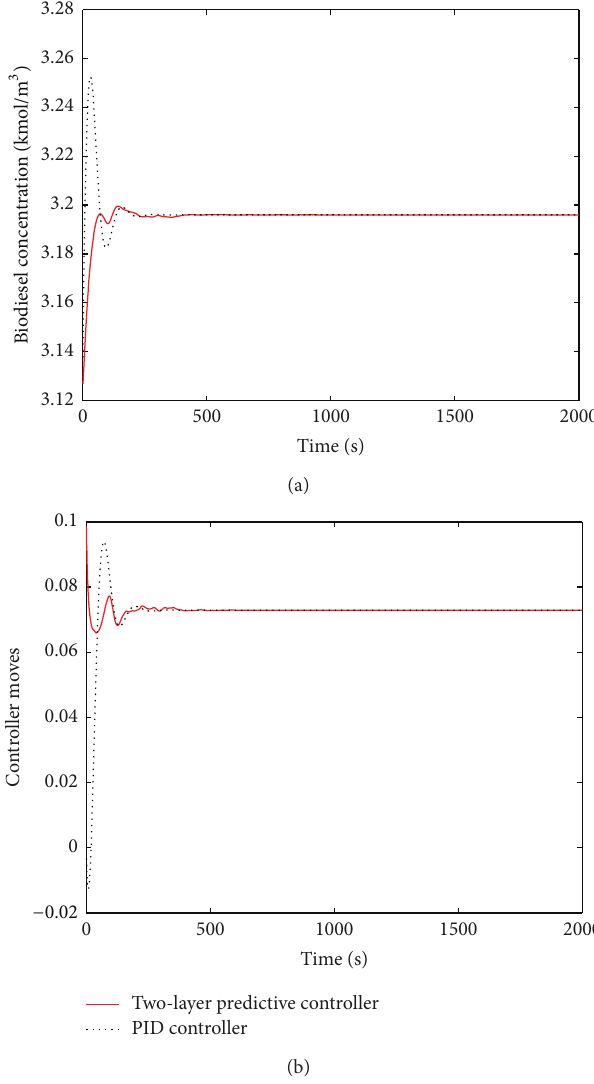
Figure 10: Biodiesel concentration and controller moves of two- layer predictive controller and PID